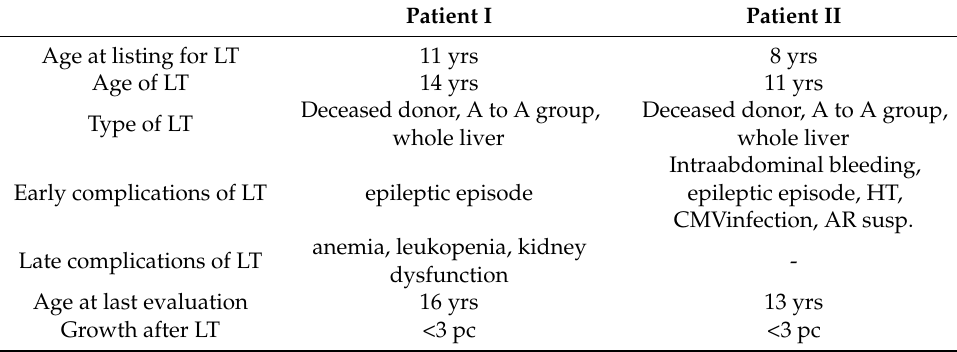
Table 2. Trasplantation details and postLT follow-up of Patients I and